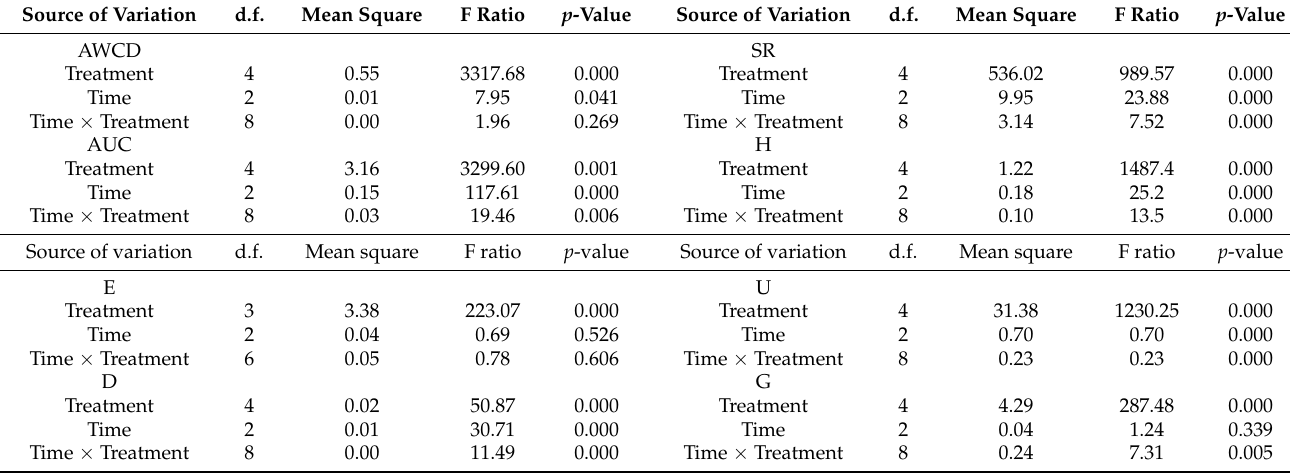
Table 2. RMANOVA results over time to evaluate effects of nZnO treatment on the freshwater microbial diversity. Bold numbers indicate significant differences at p < 0.05.